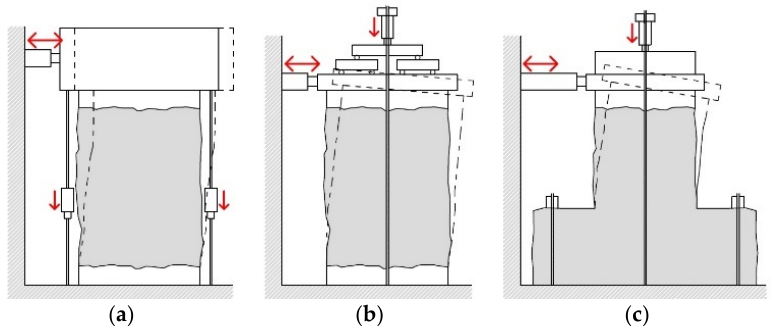
Figure 3. Schematization of different setups for tests on masonry piers under in-plane loading: ( a ) shear type, ( b ) cantilever and ( c ) reversed-T